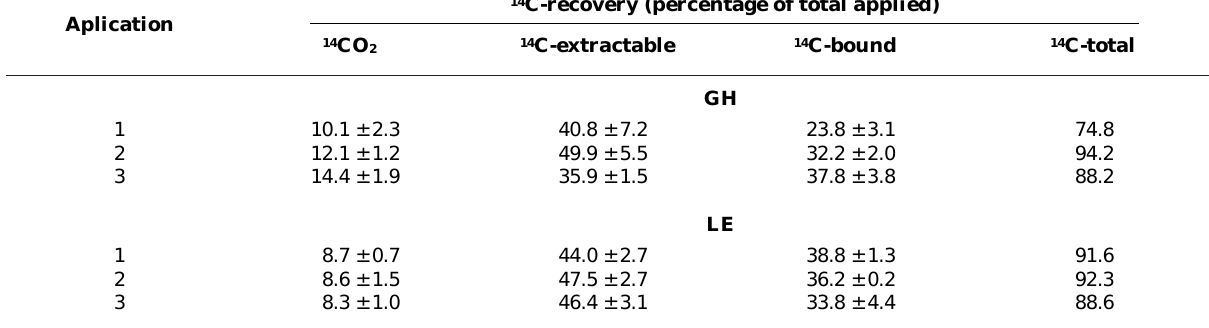
Table 1. Radiocarbon recovery after 14 C-metalaxyl successive applications of a commercial formulation in GH and LE soils (percentage of radiocarbon applied ± standard